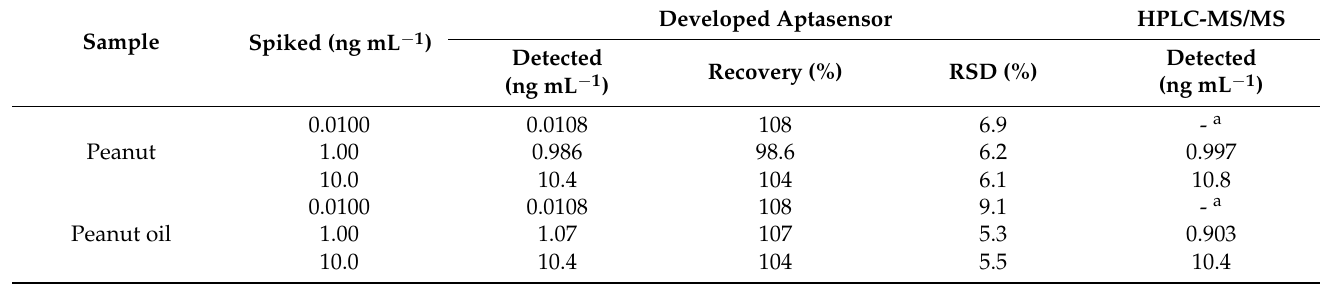
Table 2. Determination of AFB2 in peanut and peanut oil with the proposed aptasensor (n = 3) and